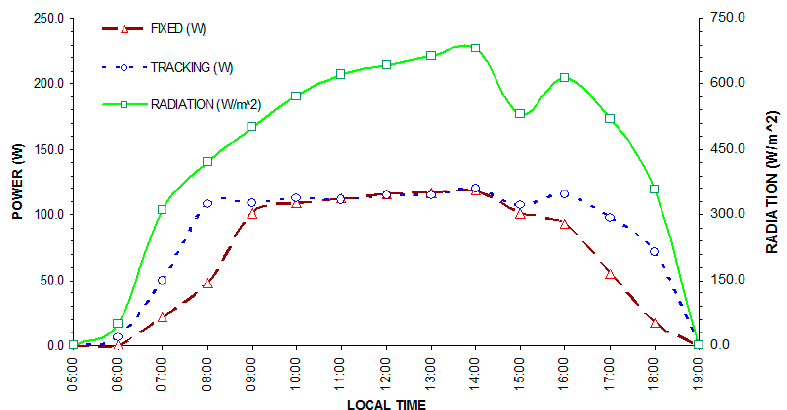
Figure 14. Power and production from fixed and tracking PVs.